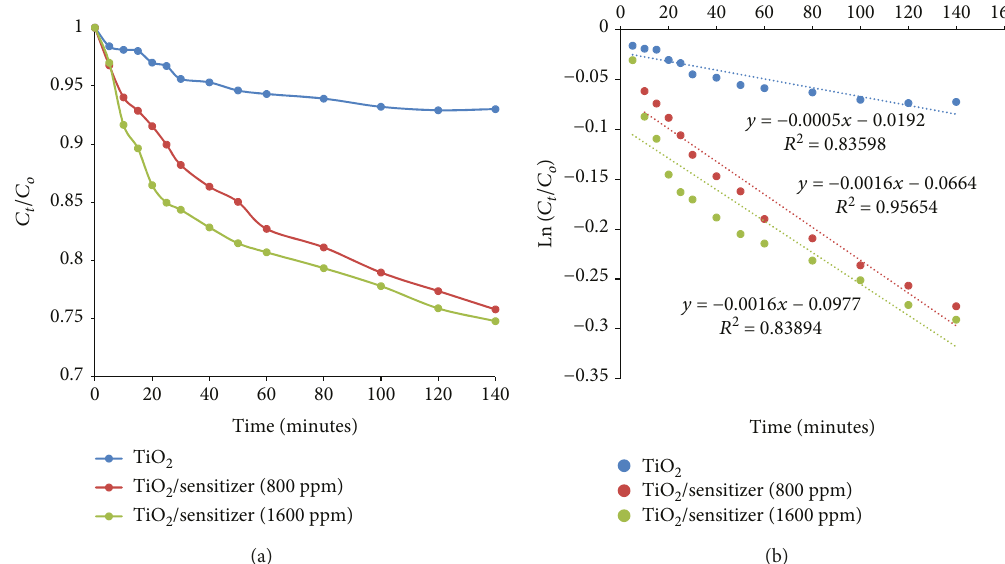
/ C ) vs. ( t ) for test. C refers to concentration at time t of MB, t o t